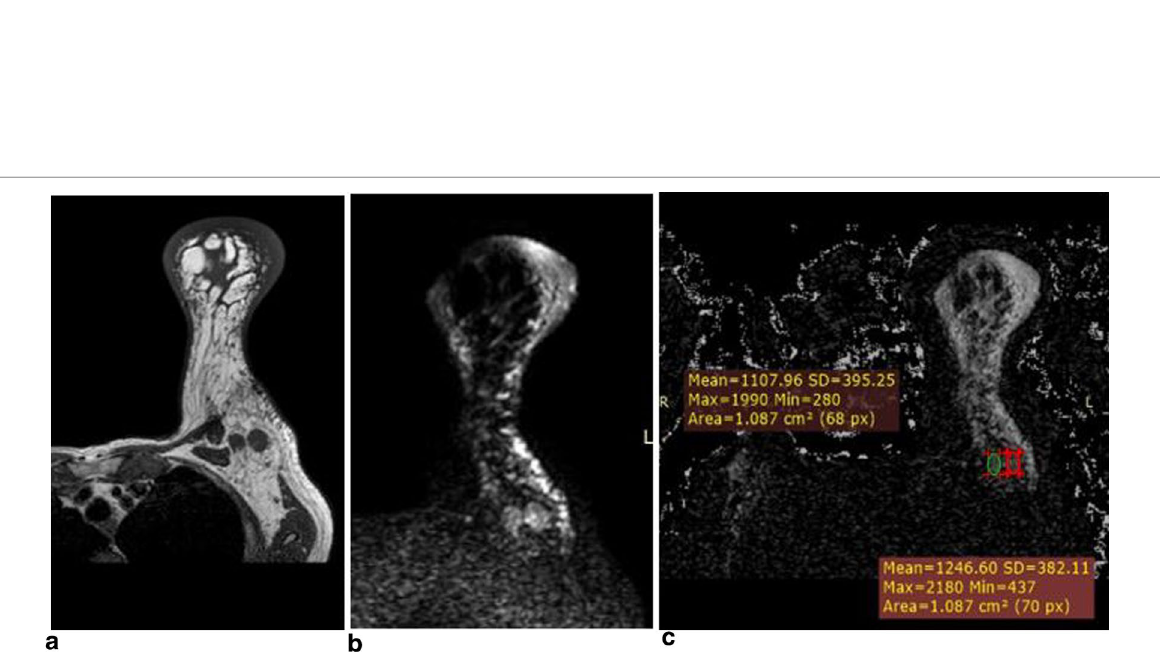
Fig. 4 A 62-year-old female a T1W1 demonstrate enlarged two left axillary LNs with lost hilum, b , c DW-MRI and ADC map showing non-restricted diffusion, ADC value (1.107 10 − 3 mm 2 /s and 1.246 10 − 3 mm 2 /s) proved to be benign in histopathological × ×